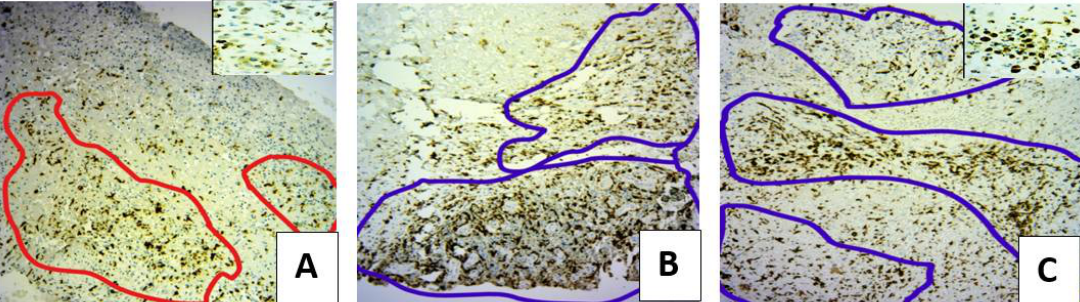
Figure 5. Distribution of CD163 + M2 macrophages in the ulcer bed on day 21 of treatment. Immunostaining to CD162 + cells in biopsies of patient with SuDe ( A ) and SuDe + Lp ( B , C ) treatment. Score density 1/3 (pattern of diffuse distribution, A ), score density 3/3 (pattern of bottom distribution, B ) and score density 2/3 (pattern of band distribution, C ). Photos were taken with 20 × objective. ( A , C ), upper left quadrant shows a 40 × magnification.